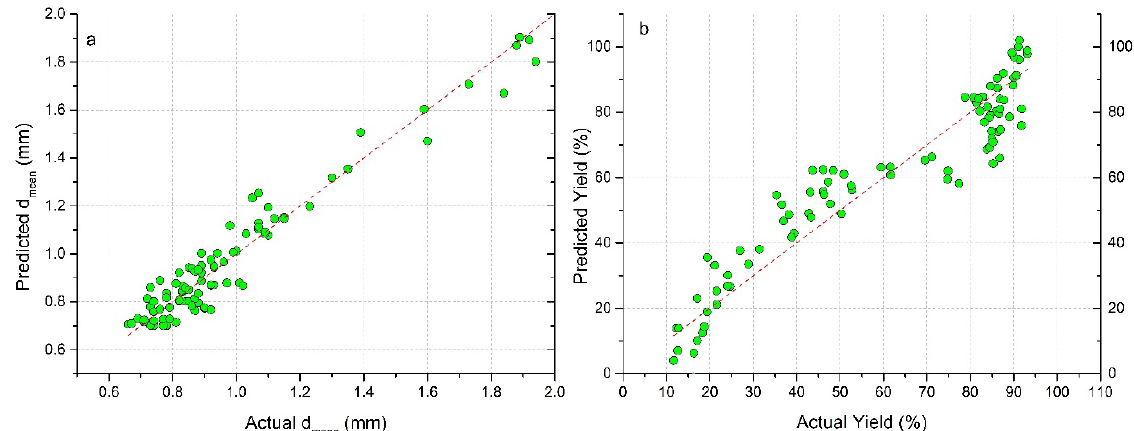
Figure 15. Relationships between experimental and predicted data: ( a ) model for prediction of mean granule size, ( b ) model